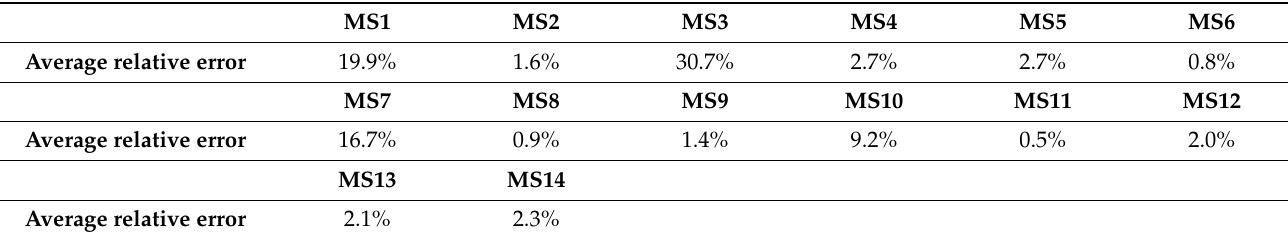
Table 4. Prediction of mobile sensors with different acquisition